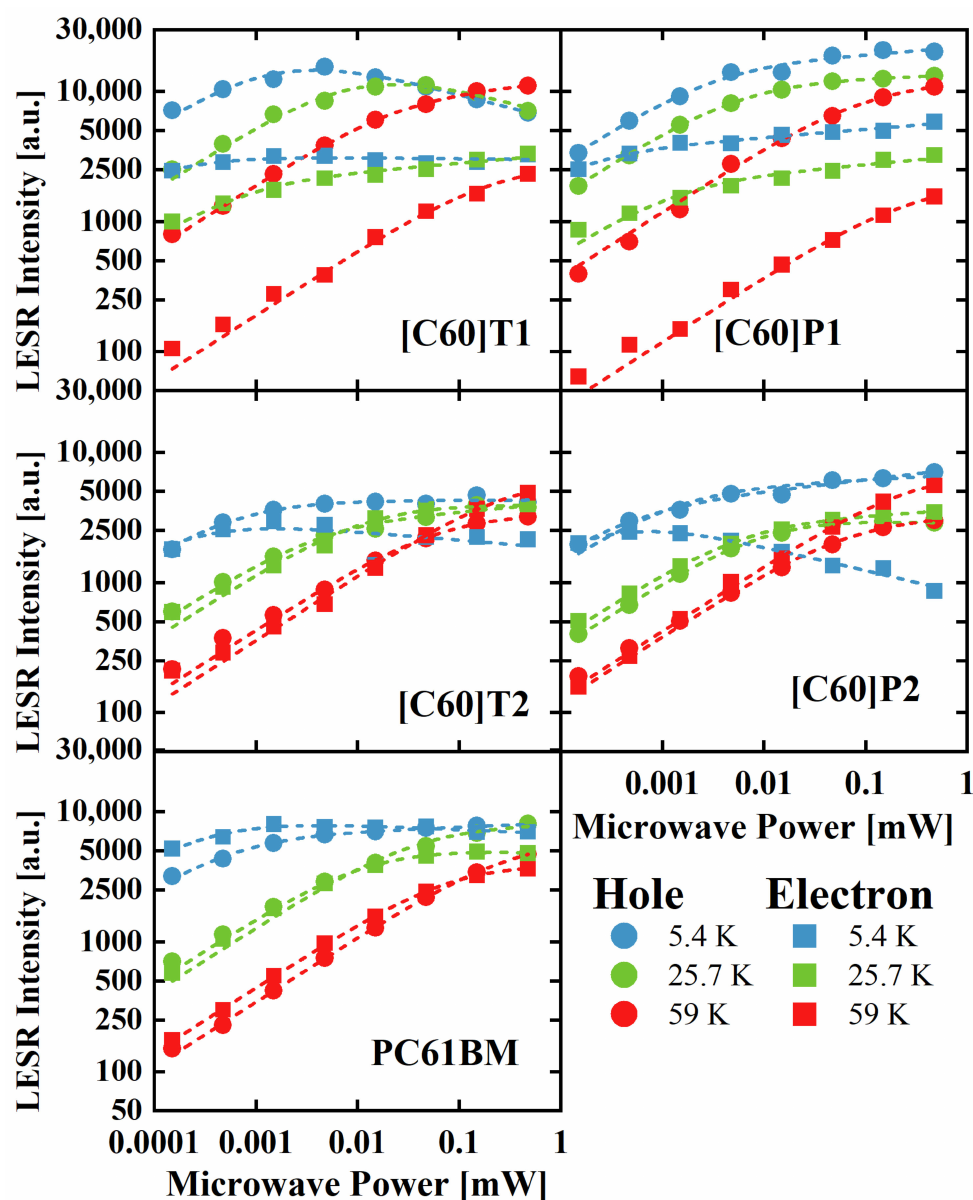
Figure 6. LESR signal intensities as a function of microwave power shown in log–log scale. The indi- cated fullerene derivatives were measured in blends with P3HT at different temperatures (the results for three selected temperatures are presented). The dashed lines were fitted with the experimental points using Formula